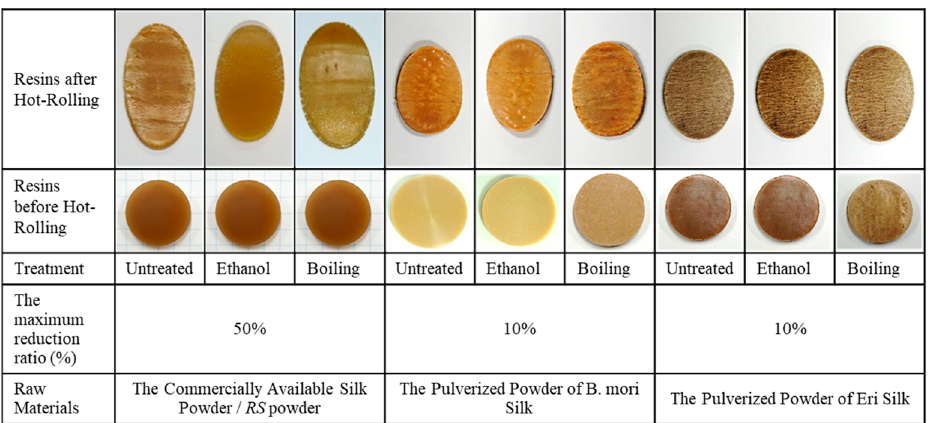
Figure 3. The appearance of the silk resins before and after the hot-rolling. The rolling reduction ratio indicates the maximum rolling reduction ratio here.